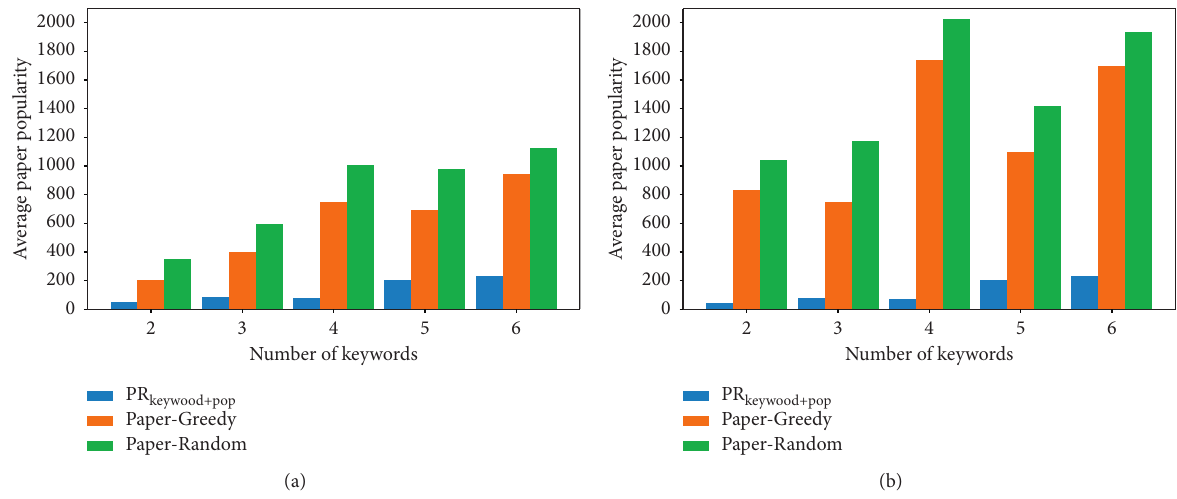
Figure 10: The average paper popularity of different approaches: (a) set A and (b) set